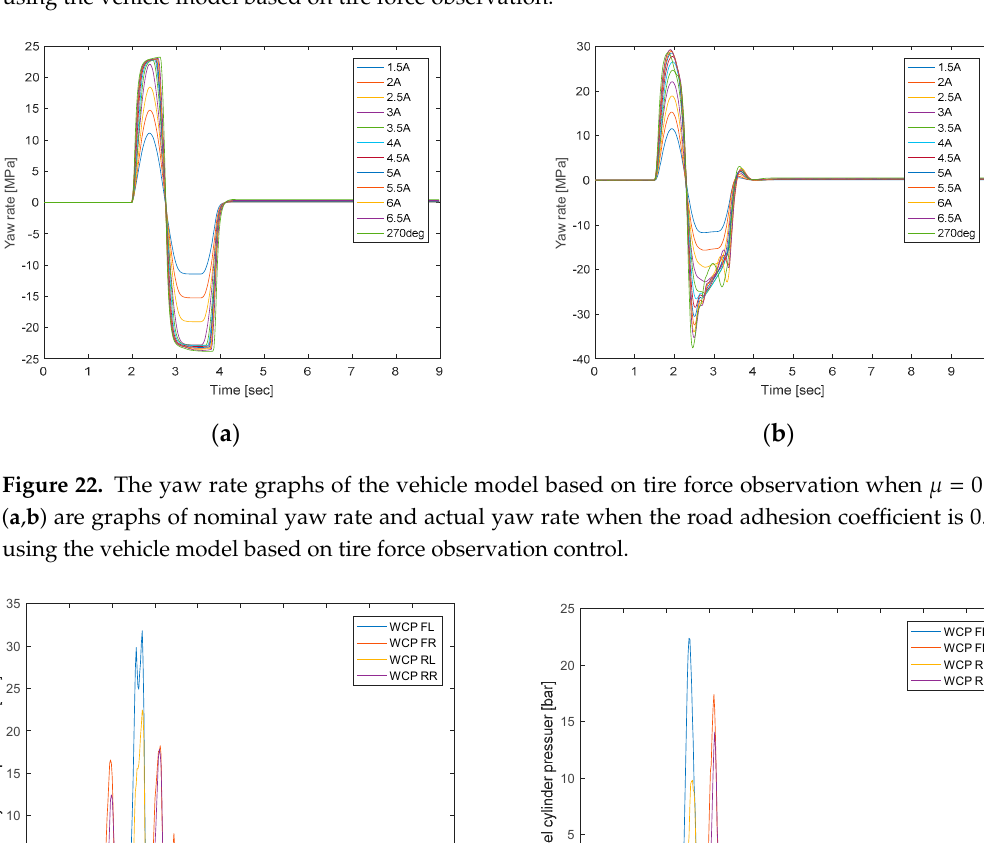
( b ) Figure 24. The yaw rate graphs of the vehicle model based on traditional PID control when 𝜇 = 0.5. ( a , b ) are the nominal yaw rate and actual yaw rate of the vehicle model using traditional PID control when the road adhesion coefficient is 0.5. ( a )